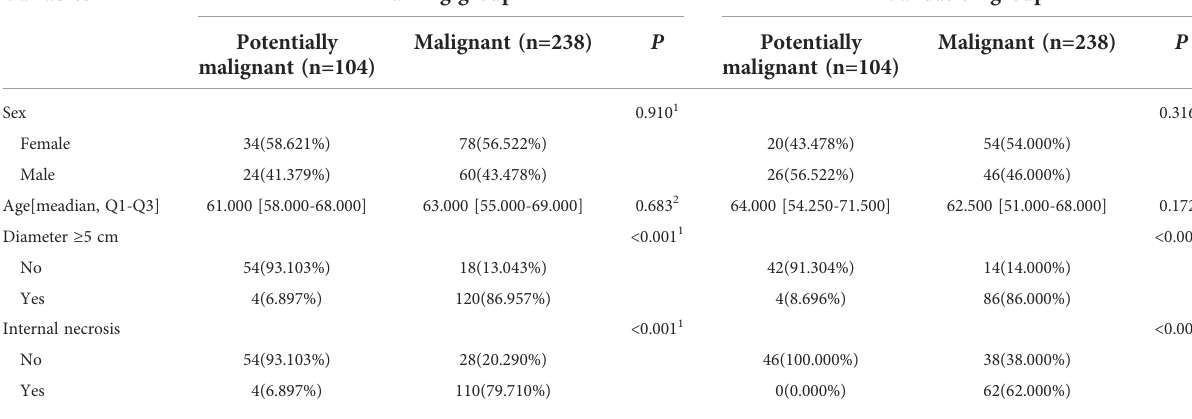
TABLE 3 Univariable analysis of potentially malignant and malignant